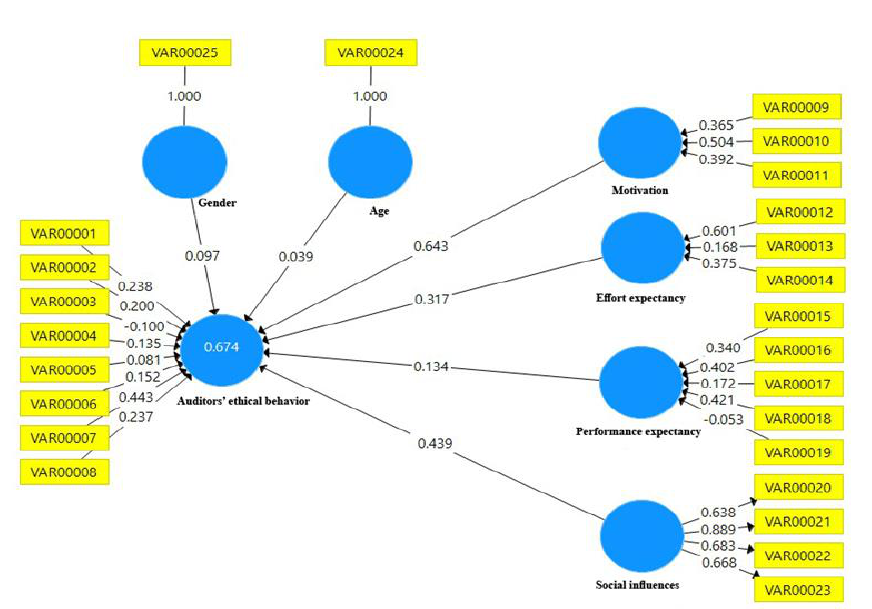
Fig. 4. PLS method of the sub-hypotheses research model